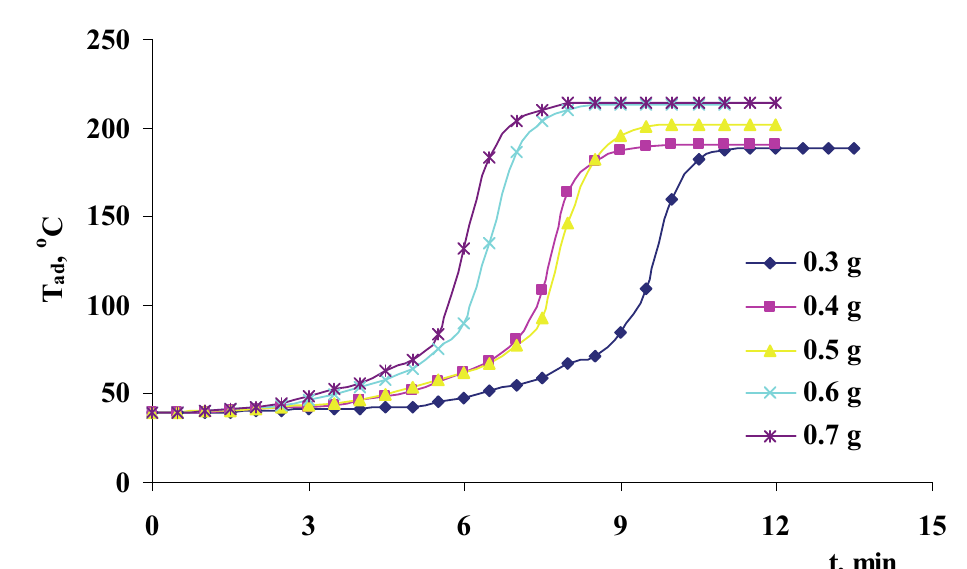
Figure 3: Changes of adiabatic temperatures with the time depending on the initiator concentration.